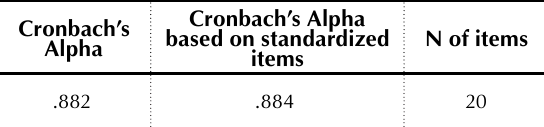
Table 1. Cronbach’s Alpha reliability